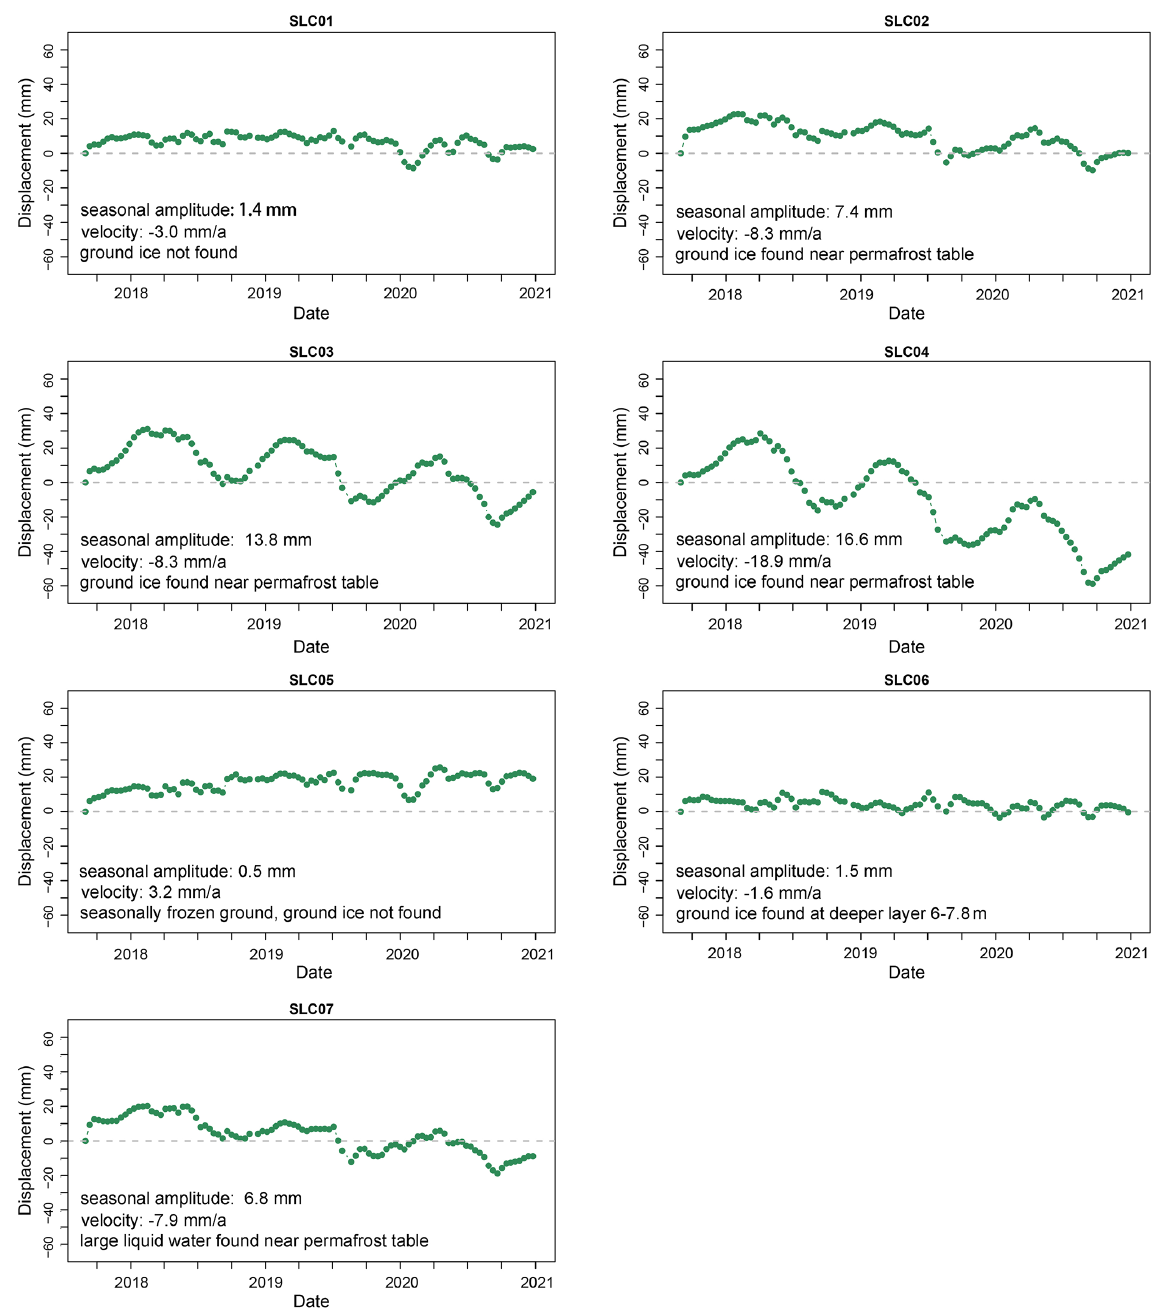
Figure 5. LOS deformation time series at the seven borehole sites. Positive values represent uplift, and negative values represent subsidence relative to the first scene of the S1